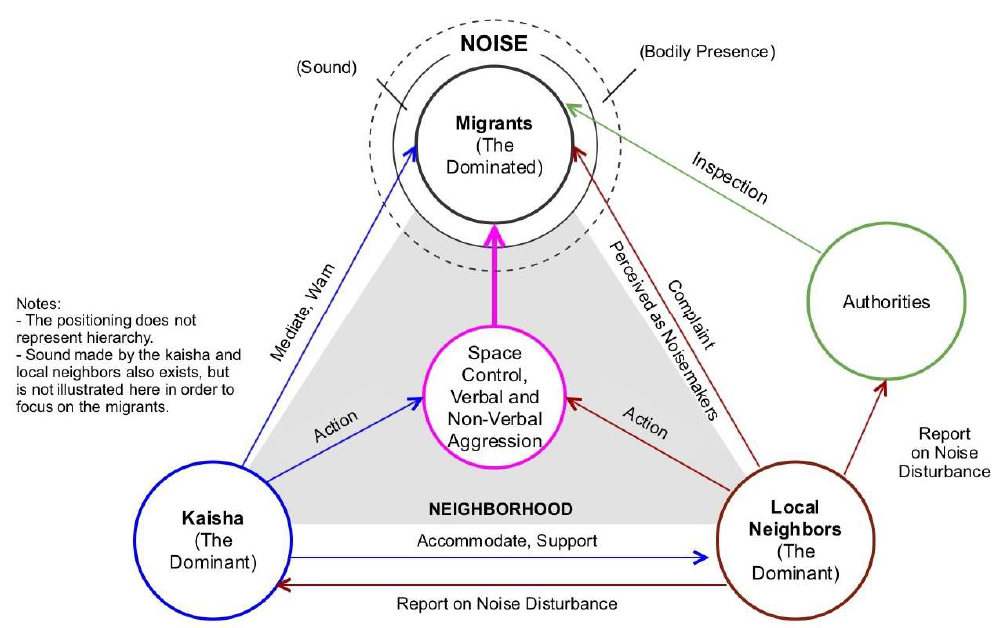
Figure 7. Noise conflict escalations in Oarai.